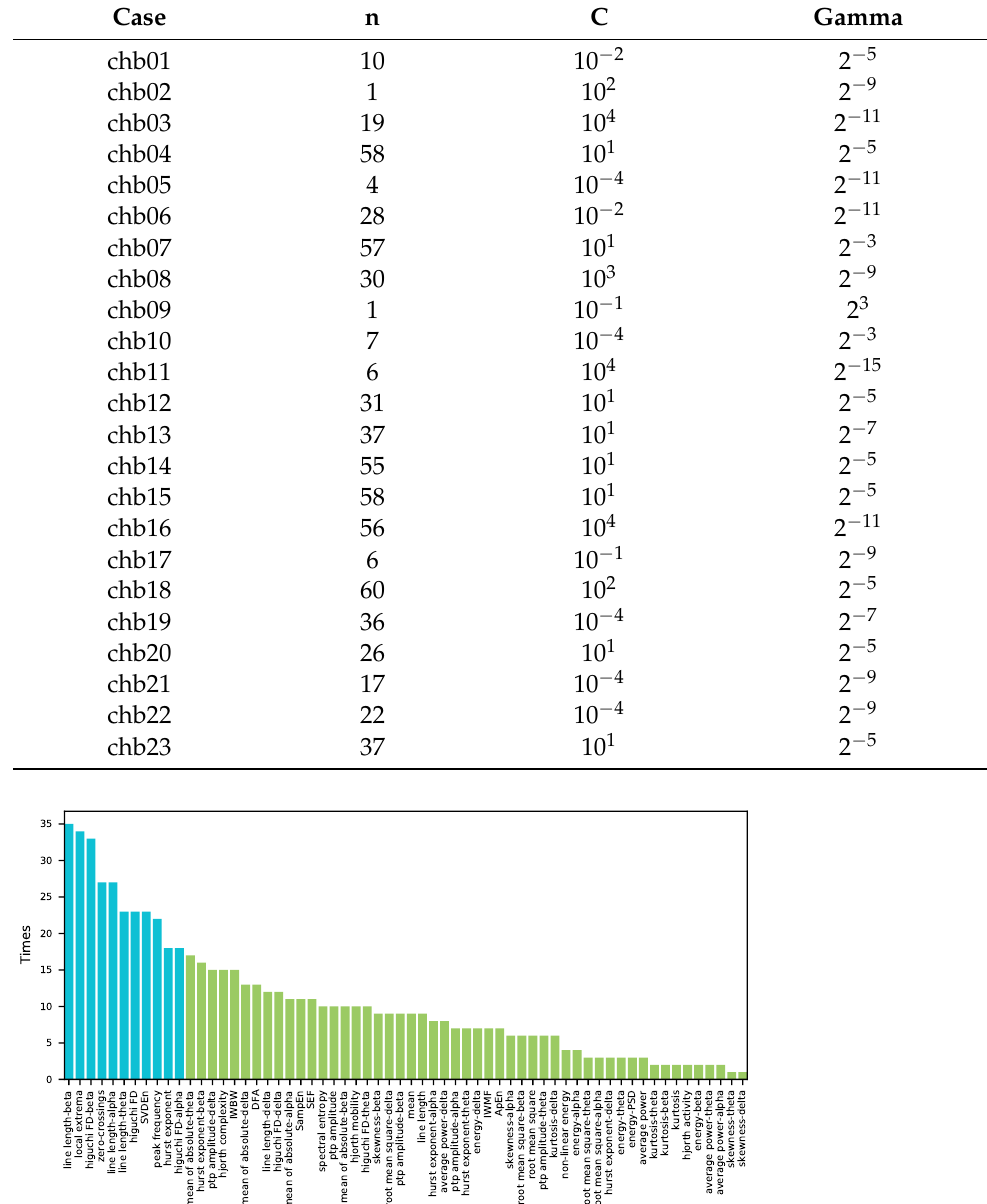
Table 3. Optimal number of features and classifier parameters for all cases. n: the number of items in optimal channel-based feature combination. C, gamma: SVM classifier hyperparameters.